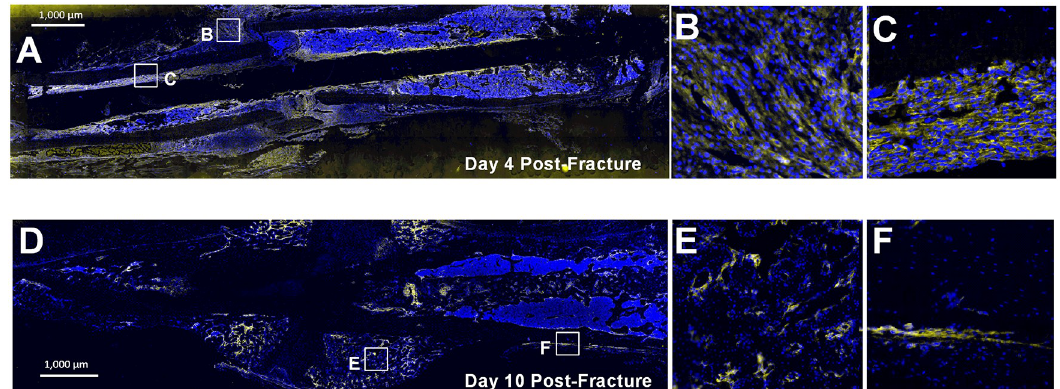
Fig 1. PDGFR β is highly expressed in the periosteum post-fracture. (A) 10x stitched tile scan image and (B,C) 100x magnification of selected locations (boxes) showing expansive PDGFR β expression in the periosteum day four post-fracture. (D) 10x stitched tile scan image and (E,F) 100x magnification of non-cartilaginous areas of the fracture callus day ten post-fracture. B,E are located close to the fracture site, while C, F are distal to the fracture site showing activated periosteum. Blue = DAPI. Yellow = PDGFR β immunostaining. Scale bar indicates 1,000 μ